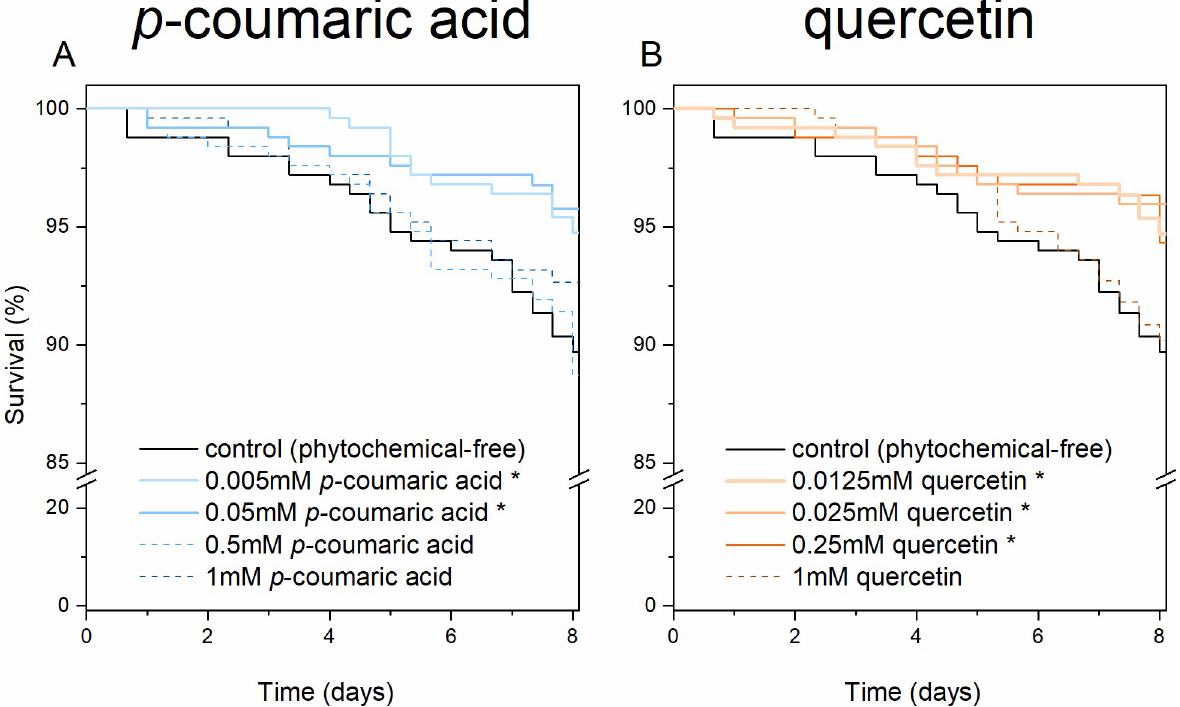
Fig 1. Kaplan–Meier plots of honey bee longevity with dietary amendments at a range of concentrations. (A) p -coumaric acid and (B) quercetin. (n = 1 250 for each phytochemical group and n = 250 for each phytochemical concentration subgroup, solid line and � = p < 0.05, Tarone-Ware test between the treatment and